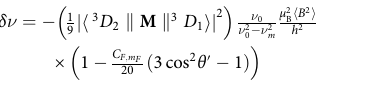
Table 1 Potential systematic shifts for 176 Lu + clock transitions